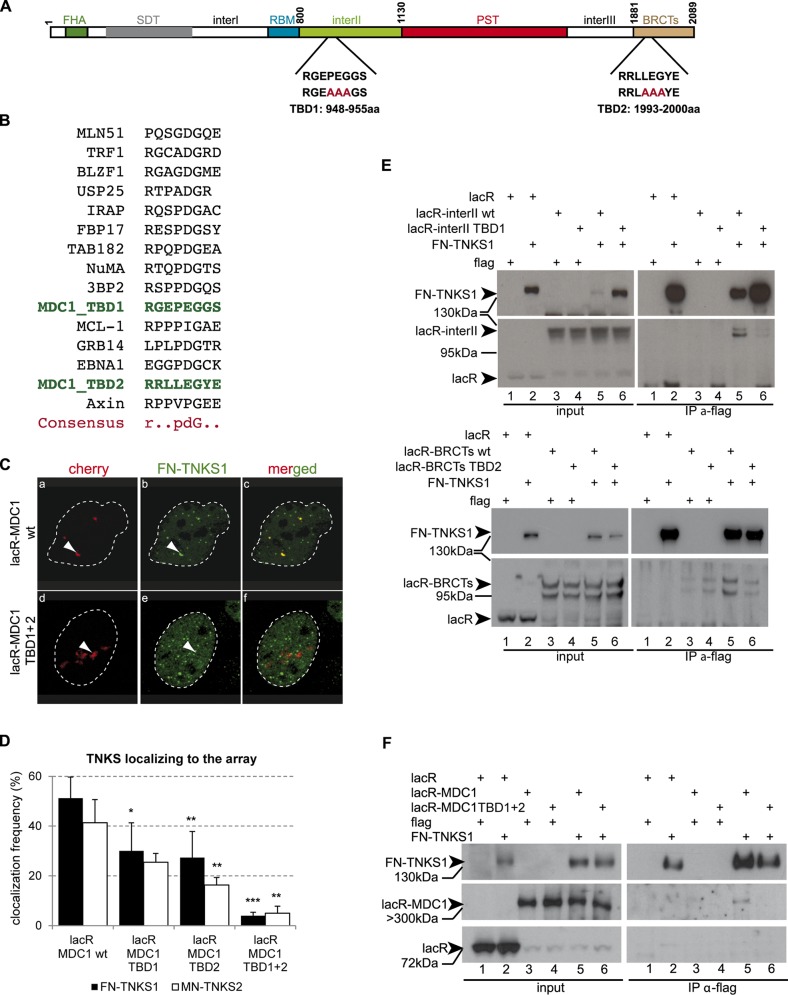
The two Tankyrase binding domains of MDC1 act cooperatively.(A) Schematic representation of MDC1 and the two predicted TBDs with their sequences highlighted. Directed mutagenesis was conducted to replace 3 amino acids of each TBD to Alanine (shown in red capital letters). (B) Multiple alignment of known TBDs from the literature and the consensus sequence. The two predicted TBDs of MDC1 are highlighted in green. (C) Immunofluorescence staining of U2OS17 cells co-transfected with FN-TNKS1 and mCherry-lacR-MDC1 wild type or mCherry-lacR-MDC1 TBD mutant. The mutant version does not colocalize any more with TNKS. (D) Quantification of the colocalization frequency of full-length mCherry-lacR-MDC1 (wt or TBD mutants) and TNKS1/2. Disruption of the two TBDs by directed mutagenesis leads to the loss of colocalization. Values represent mean ± SD from three independent experiments (N = 100 cells in each experiment). (E)
In vivo interaction of TNKS1 and the MDC1 “interII” or “BRCTs” domain detected by co-immunoprecipitation. HEK 293T cells were co-transfected with either mCherry-lacR (lanes 1,2), mCherry-lacR-interII (lanes 3–6, upper panel) or mCherry-lacR-BRCTs (lanes 3–6, bottom panel) and FN-TNKS1 (in lanes 2, 5, 6). TBD mutant versions of mCherry-lacR-interII or mCherry-lacR-BRCTs (lanes 4, 6 on upper and bottom panel, respectively) were also included in the analysis. Immunoprecipitation was performed with the M2 flag antibody and the immunoblot was developed with an anti-lacR antibody revealing an interaction between FN-TNKS1 and lacR-interII or lacR-BRCT. Flag antibody was used to detect the presence of FN-TNKS1. Arrowheads show the specific bands. (F)
In vivo interaction of TNKS1 and MDC1 requires intact TBD domains. HEK 293T cells were transfected with mCherry-lacR (lanes 1, 2) or mCherry-lacR-MDC1 (lanes 3–6) and FN-TNKS1 (lanes 2, 5, 6). MDC1 was mutated on its two TBDs in lanes 4 and 6. Cell extracts were subjected to anti-flag immunoprecipitaton and analysed by Western Blotting. Only the wild type MDC1 co-precipitates with FN-TNKS (IP lane 5).